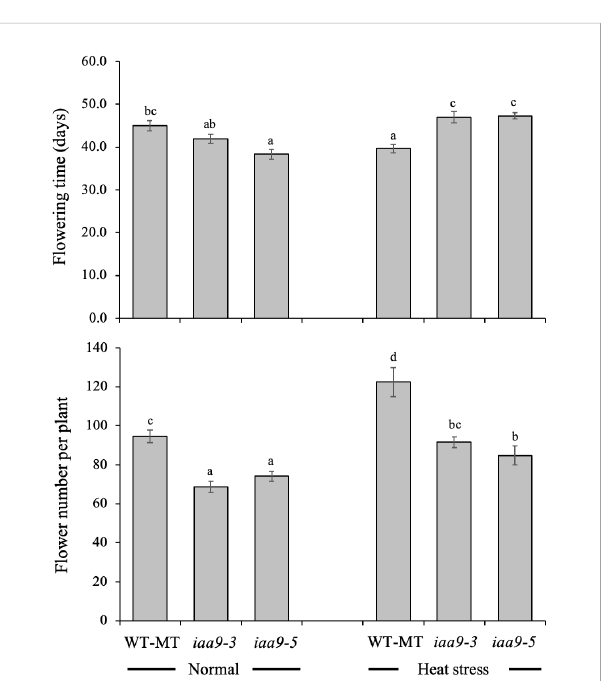
FIGURE 3 Flowering time and fl ower number per plant of WT-MT, iaa9-3 and iaa9-5 under two temperature conditions, i.e., normal temperature and heat stress condition. The average value ± standard error (SE) (n = 4) followed by the same lowercase letters is not signi fi cantly different based on Duncan ’ s Multiple Range Test at